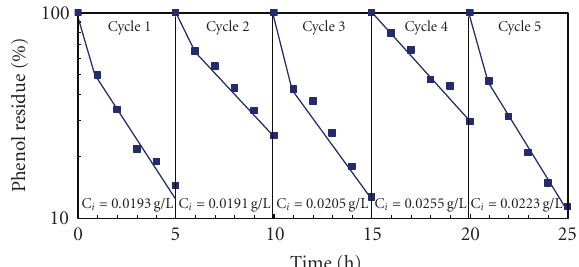
Figure 15: Cycling decomposition of phenol under UV irradiation and H 2 O 2 on Fe-modified carbon-coated TiO 2 photocatalyst heat treated at 400 ◦ C.